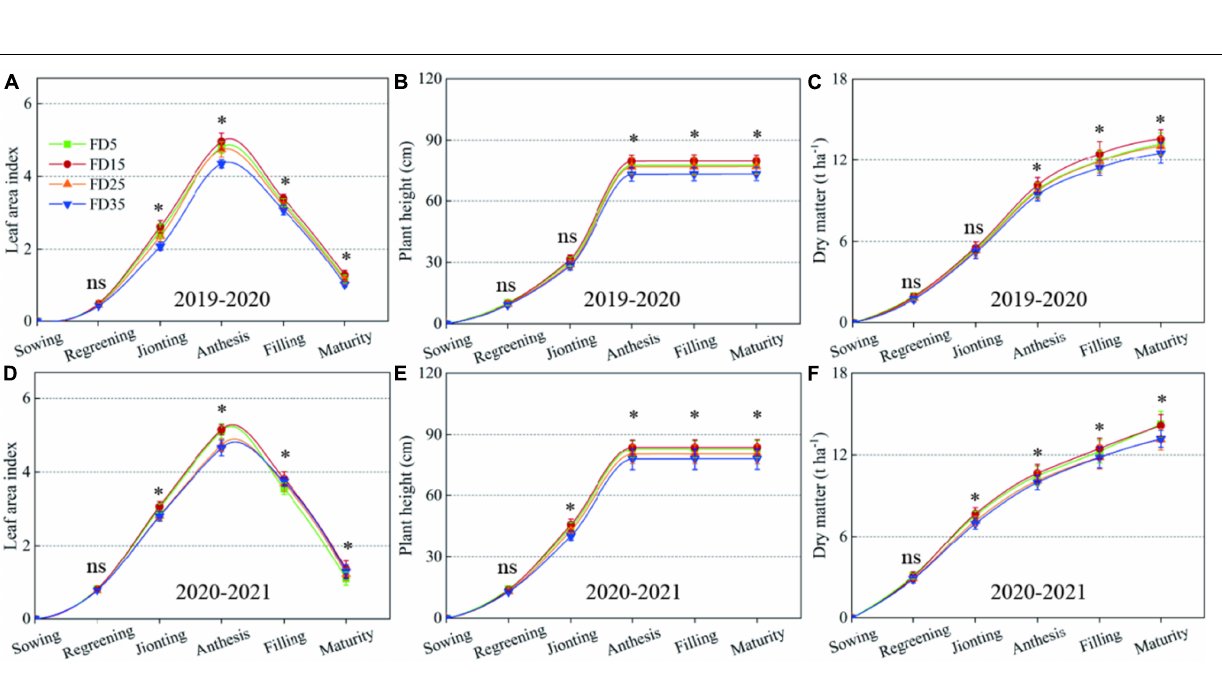
Frontiers in Plant Science |